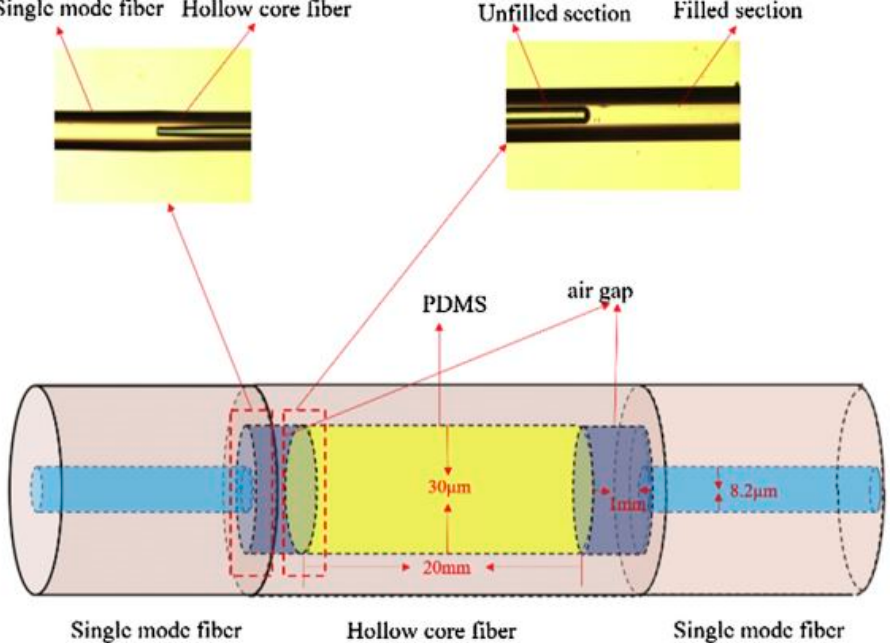
Figure 10. Temperature sensor with PDMS/silica hybrid fiber structure [83].